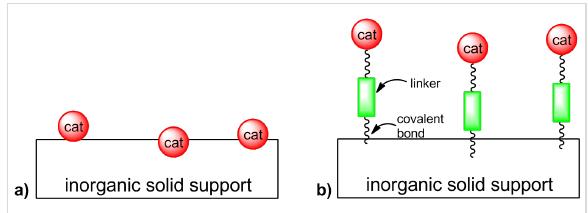
Figure 1: Anchoring methodologies: a) impregnation; b) covalent